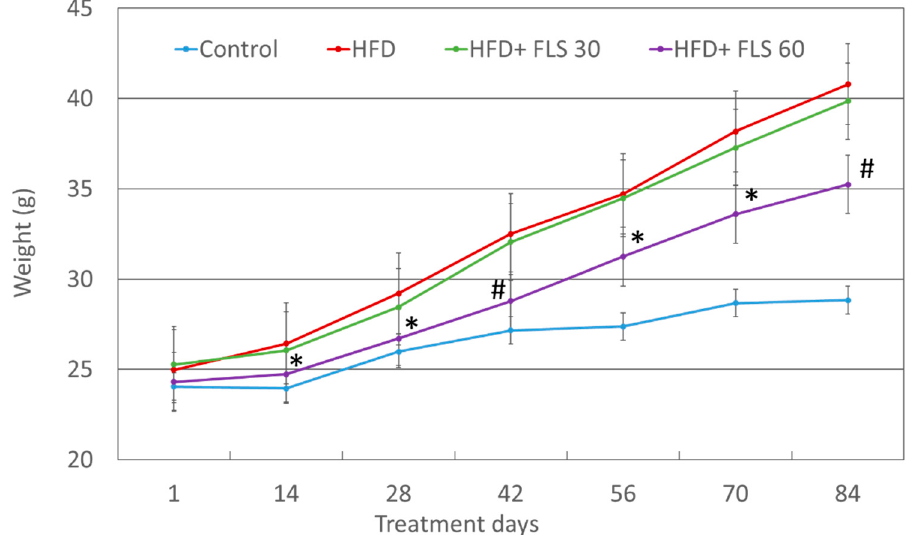
Figure 2. Average weight of the experimental groups of mice throughout the whole duration of the experiment. Error bars represent the standard error of the mean. *, p < 0.05; #, p < 0.01 compared to the HFD group.